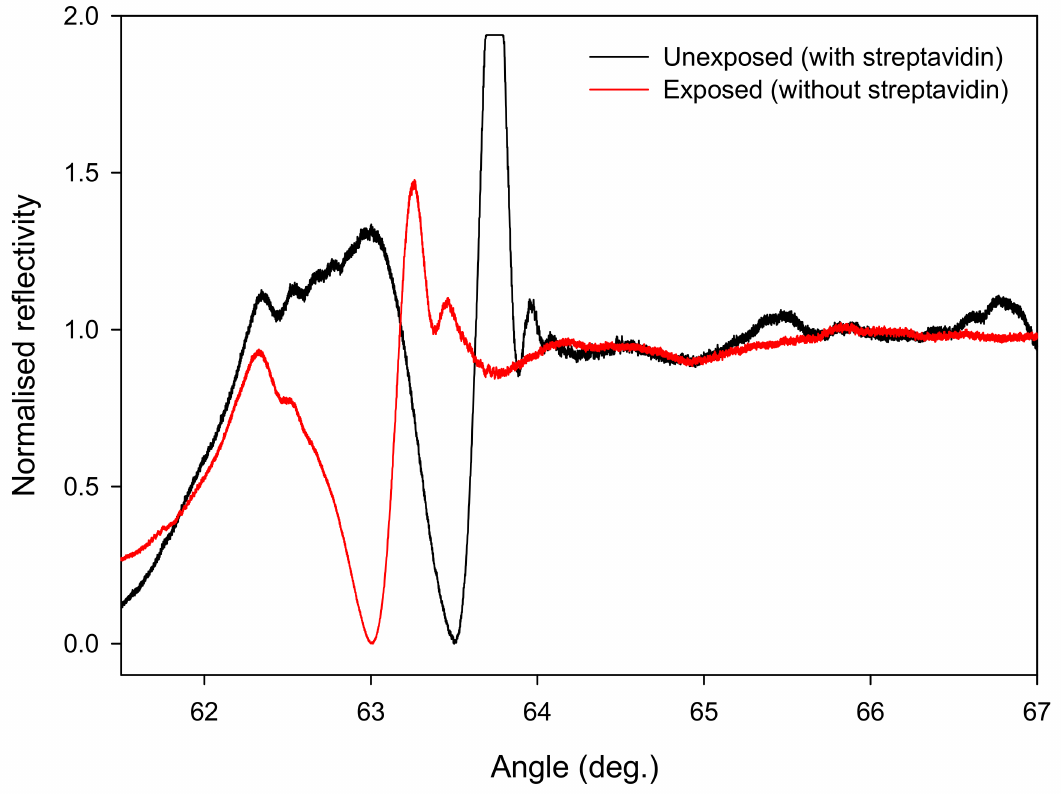
Figure 5. Normalised reflectivity curves of the regions of di ff raction-based LWs with and without immobilised streptavidin (where angle is θ ext as marked in Figure